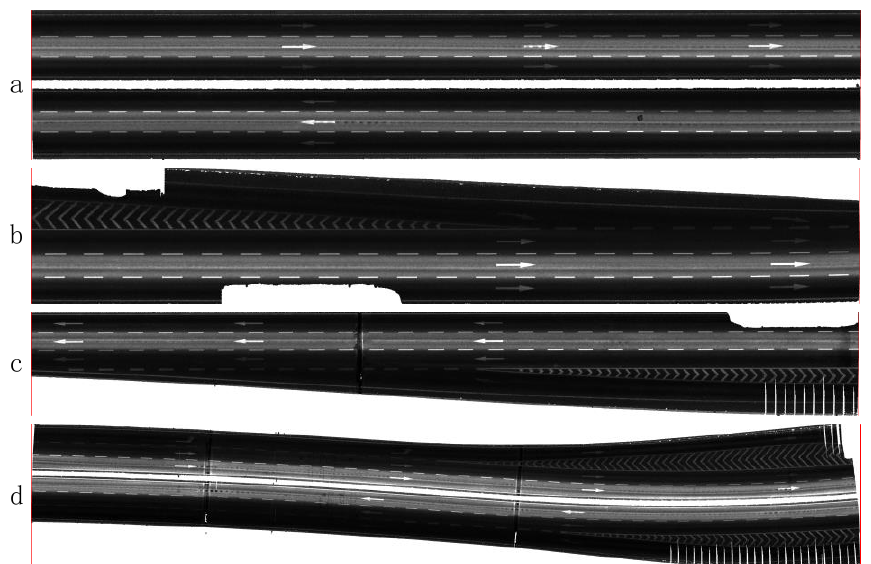
Figure 14. The raster image of the point cloud. ( a ) Raster image converted from area A2; ( b ) Raster image converted from area A3; ( c ) Raster image converted from area A4; ( d ) Raster image converted from area A1.